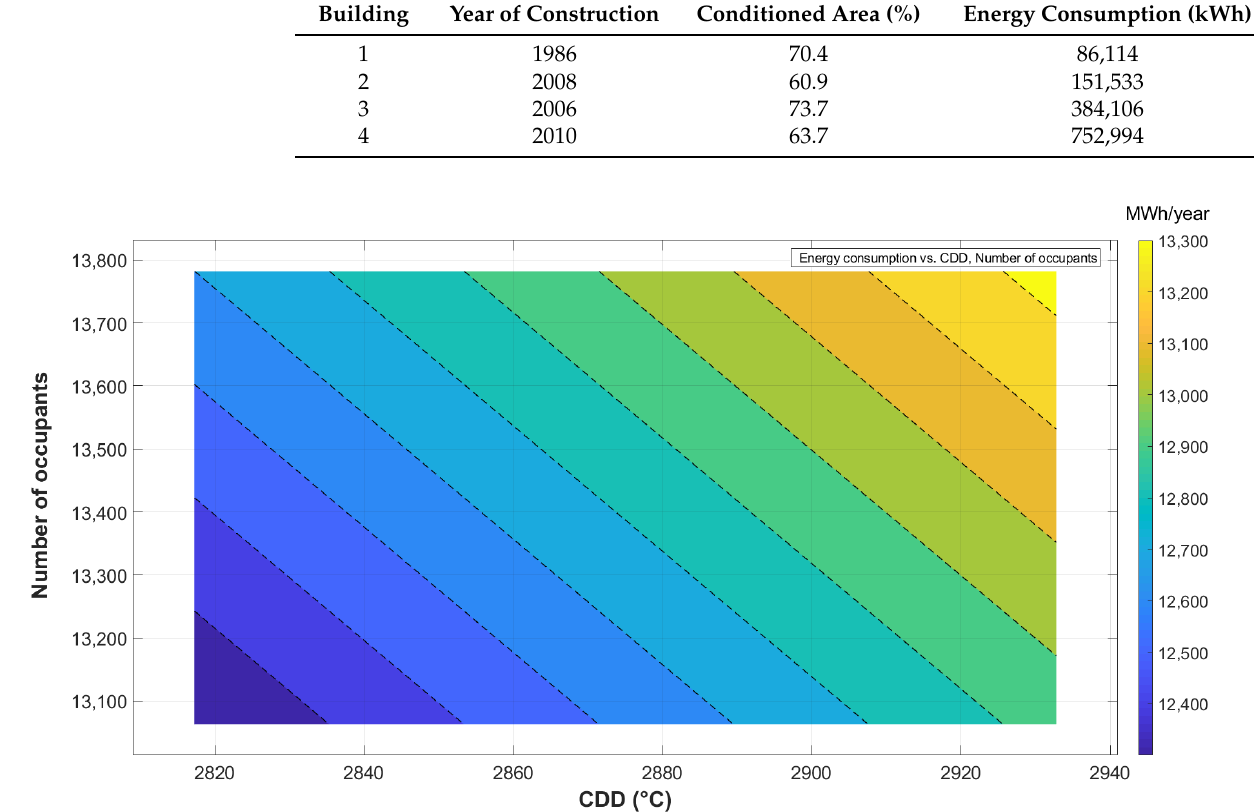
Figure 5. Contour plot of the relationship between the energy consumption, CDD, and number of